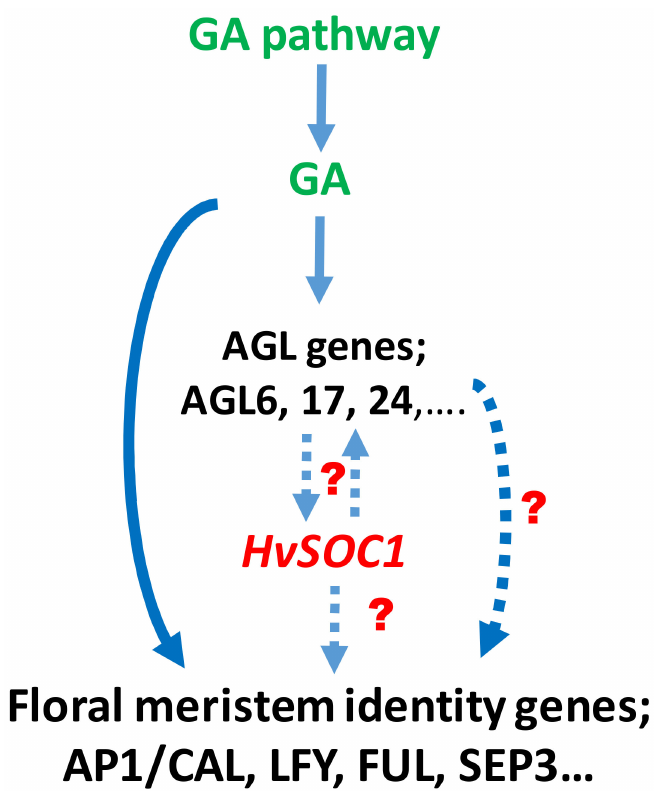
Figure 5. Suggested role of HvMADS56 ( HvSOC1 ) in regulating spikelet development in bar- ley through its direct effect on the floral meristem identity genes or through stimulation of the AGAMOUS-like (AGL) genes activity. Hypothetical interactions that need further investigations in barley are indicated by dotted